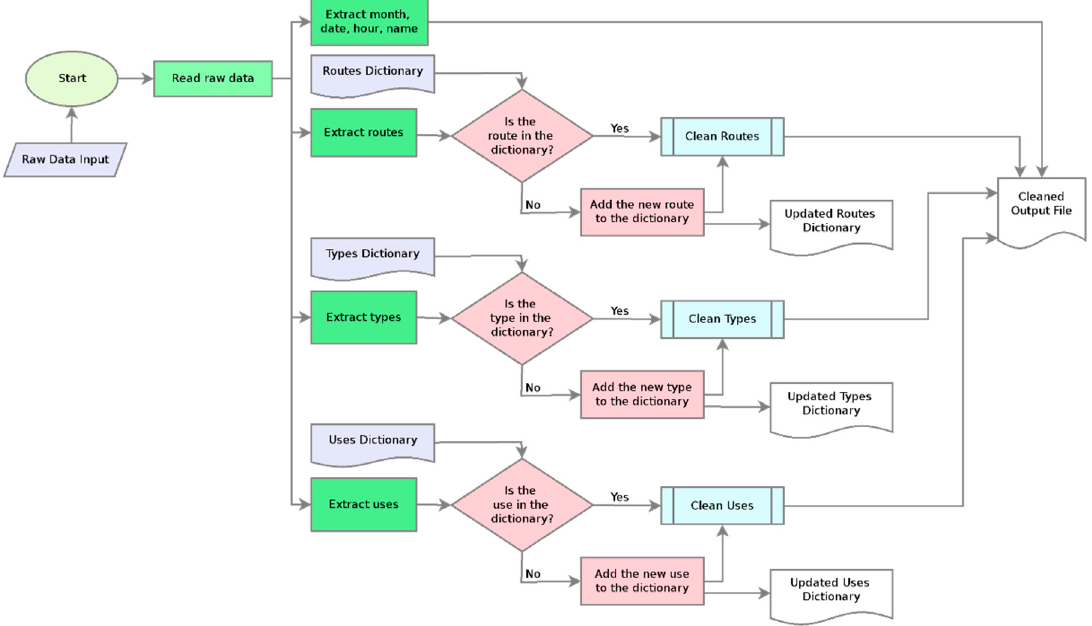
Figure 4. Flowchart illustrating raw data cleaning and dictionary updating procedures.